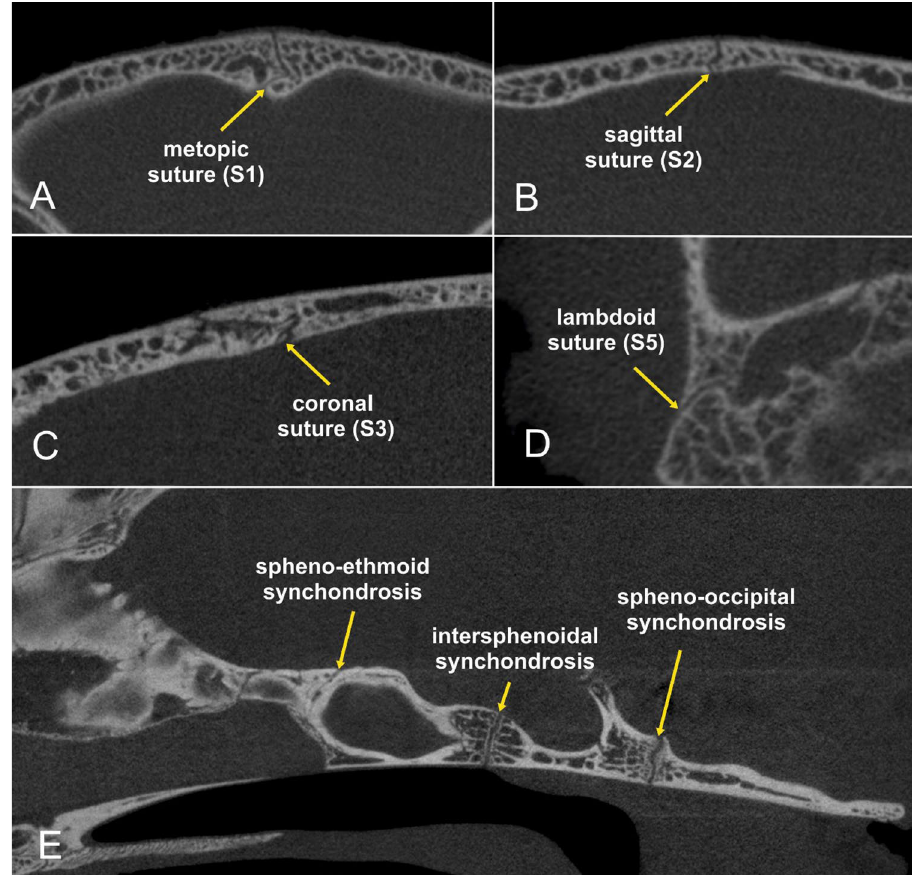
Figure 3. Micro-CT images of a skull specimen of a 6-month-old Domestic Shorthair cat in a transverse ( A , B ), sagittal ( C , E ) and dorsal view ( D ). The presented sutures and synchondroses separate the adjacent skull bone by a hypodense line of variable shape. The two ends of the coronal suture overlapped (sutura squamosa) leaving thin sutural gaps. Straight-edged plane suture ends were found in the lambdoid suture. The sagittal and metopic sutures had a serrated morphology, with the bone edges having a saw-like appearance. Synchondroses were visible as large, straight-edged or curved hypodense gaps between the basioccipital and sphenoid bone (spheno-occipital synchondrosis), the basisphenoid and presphenoid bone (intersphenoid synchondrosis) and the presphenoid and ethmoidal bone (spheno-ethmoidal